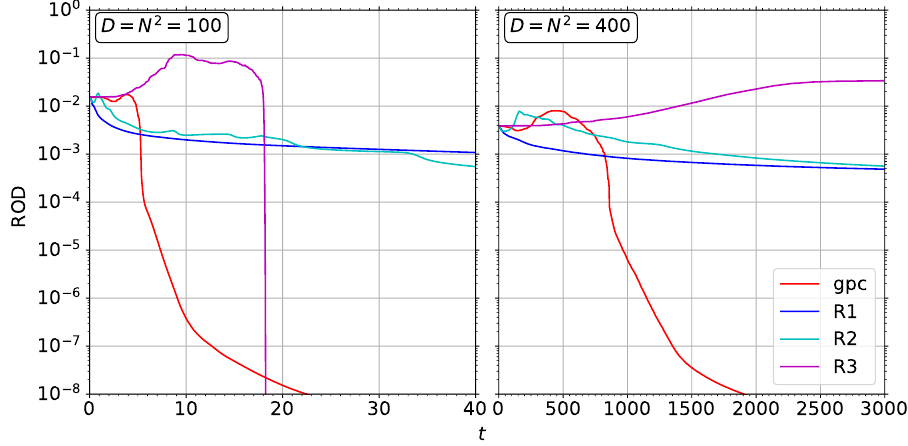
Figure 13: ROD flow of random Lindbladians, defined in Sec. 4.6, calculated with the gpc-generator, R1-, R2- and R3-generator, for a Lindbladian with 100 ( N = 10) and 400 ( N = 20)